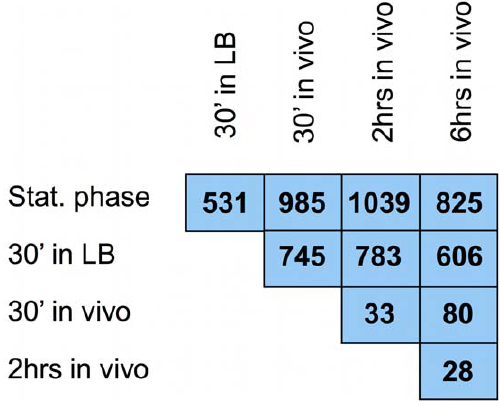
Figure 3. Matrix of significant changes in gene expression between conditions. Gene qualifiers on the microarray were considered significantly different between growth conditions if they were assigned a p , 0.05 by ANOVA and also exhibited a fold change difference of greater than or equal to 2.